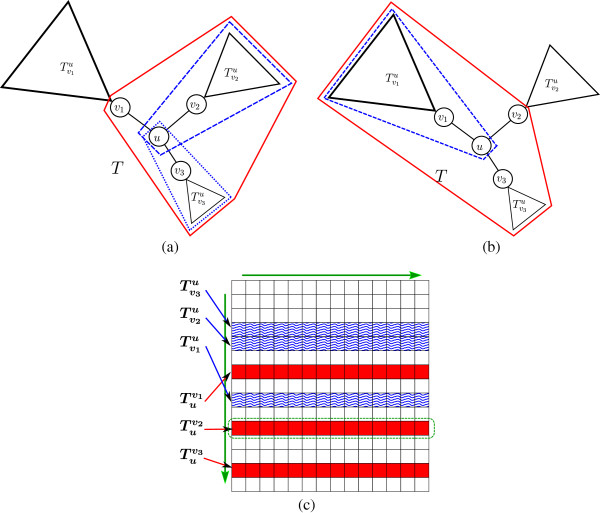
An illustration of Observation2. (a) A node u in a tree T, such that N(u) = {v1,v2,v3}, and|Tuv1|≤|Tuv2|≤|Tuv3|. The subtreeTuv1 (bounded by a solid red line) containsTv2u andTv3u as subtrees (bounded by dashed and dotted blue lines, respectively), and therefore|Tv2u|,|Tv3u|≤|Tuv1|≤|Tuv2|. (b) The subtreeTuv2 (bounded by a solid red line) containsTv1u as a subtree (bounded by a dashed blue line), and therefore|Tv1u|,|Tv2u|,|Tv3u|≤|Tuv2|. (c) The DP matrix H. The rows of the matrix correspond to subtrees of T, sorted from top to bottom with non-decreasing tree size. Rows corresponding to subtrees of the formTuvi are in solid red, and rows corresponding to subtrees of the formTviu are in waved-blue. All waved-blue rows have smaller indices than the row corresponding toTuv2 (circled with a dashed green line).